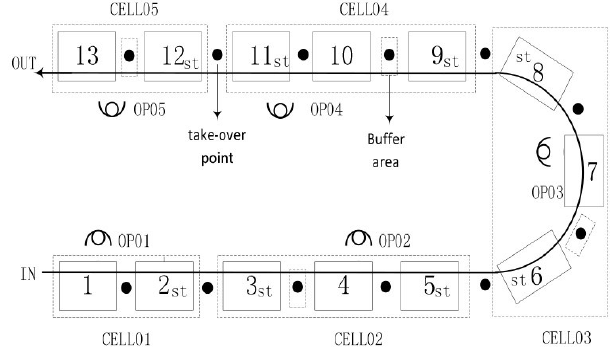
Figure 2. Shared Cell (SHC)